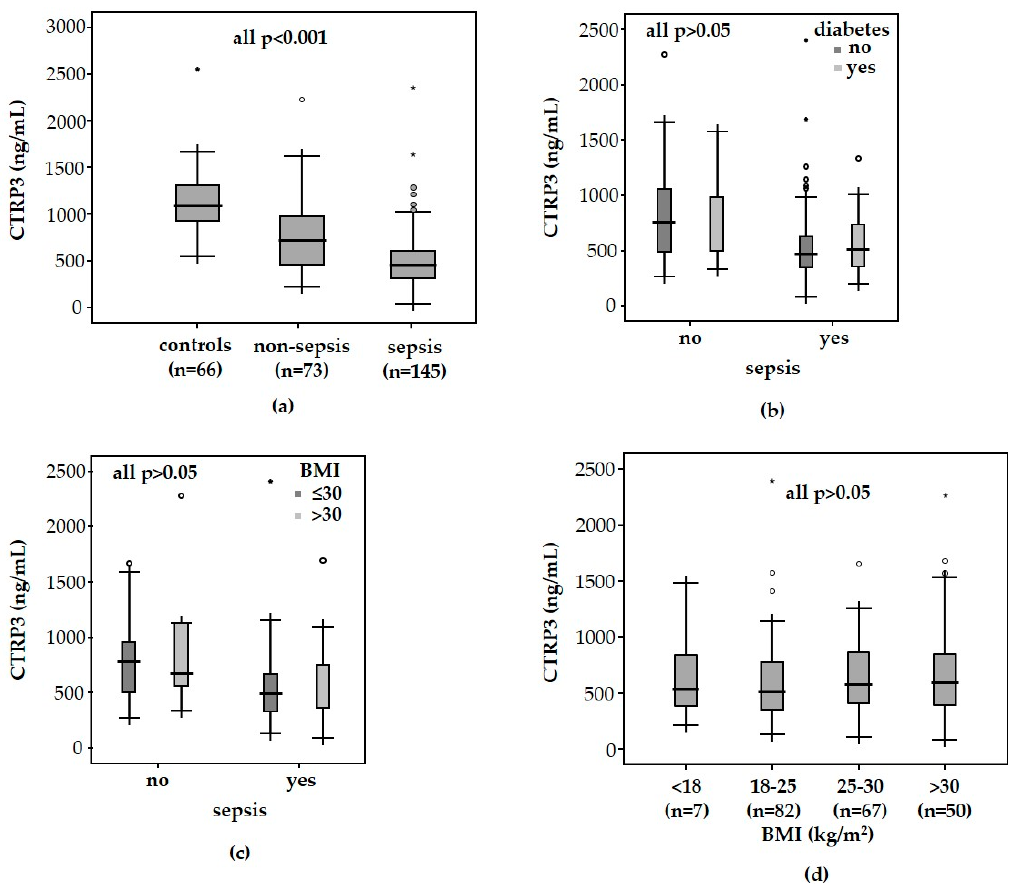
Figure 1. CTRP3 levels in critically ill patients. CTRP3 plasma concentrations are significantly decreased in critically ill patients compared with healthy controls ( a ). ICU patients with sepsis displayed significantly decreased CTRP3 levels compared to patients without sepsis ( a ). CTRP3 plasma concentrations in ICU patients are neither associated with pre-existing type 2 diabetes ( b ) nor